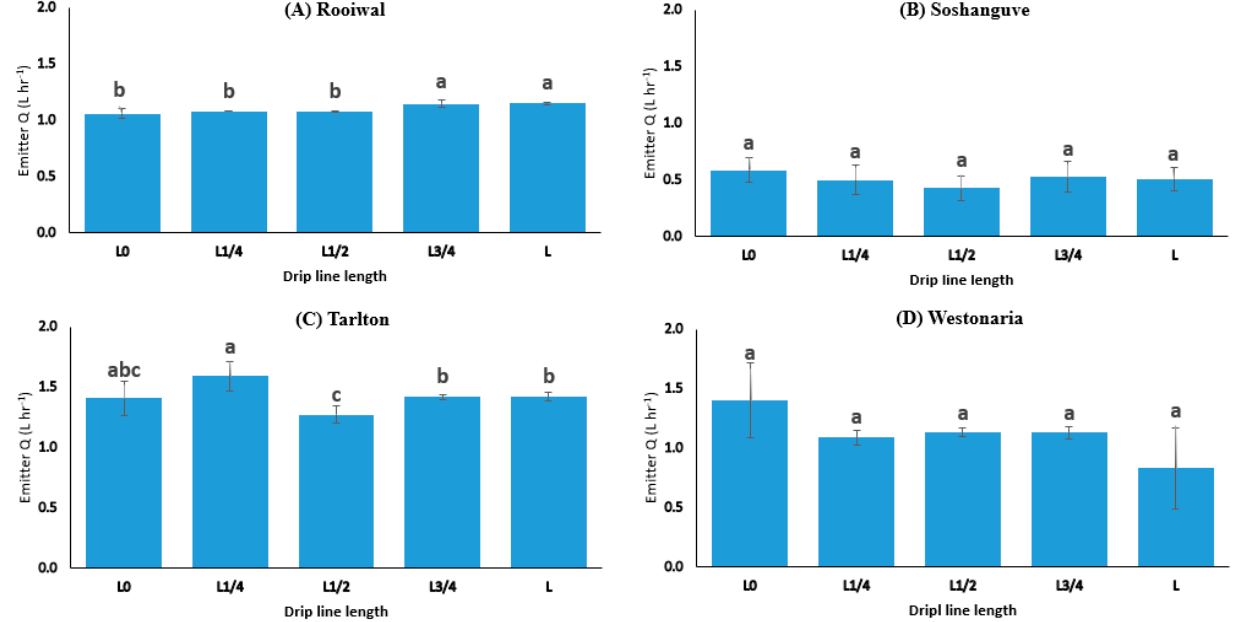
Figure 3. Mean emi tt er discharges for the di ff erent areas of drip lines at ( A ) Rooiwal, ( B ) Figure 3. Mean emitter discharges for the different areas of drip lines at ( A ) Rooiwal, ( B ) Soshanguve, Soshanguve, ( C ) Tarlton, and ( D ) Westonaria. Bars accompanied by similar le tt er in each sub fi gure ( C ) Tarlton, and ( D ) Westonaria. Bars accompanied by similar letter in each subfigure were not were not signi fi cantly di ff erent at p < 0.05. significantly different at p <